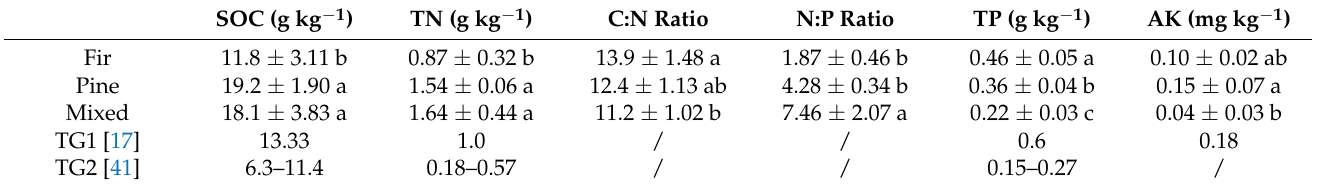
Table 2. Content of macroelements in soils of different forest types.